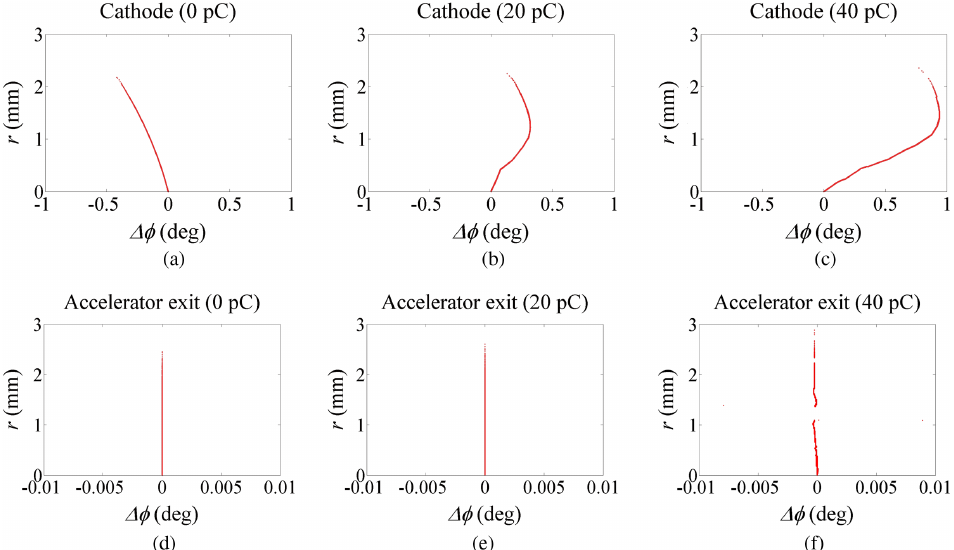
FIG. 9. Studies similar to Fig. 8, except that the initial transverse electron distribution at the cathode is Gaussian with an rms radius of 0.5 mm. With the space charge effects, the amount of required IPC is larger and more nonlinear, compared with that for a transversely flattop beam in Fig.